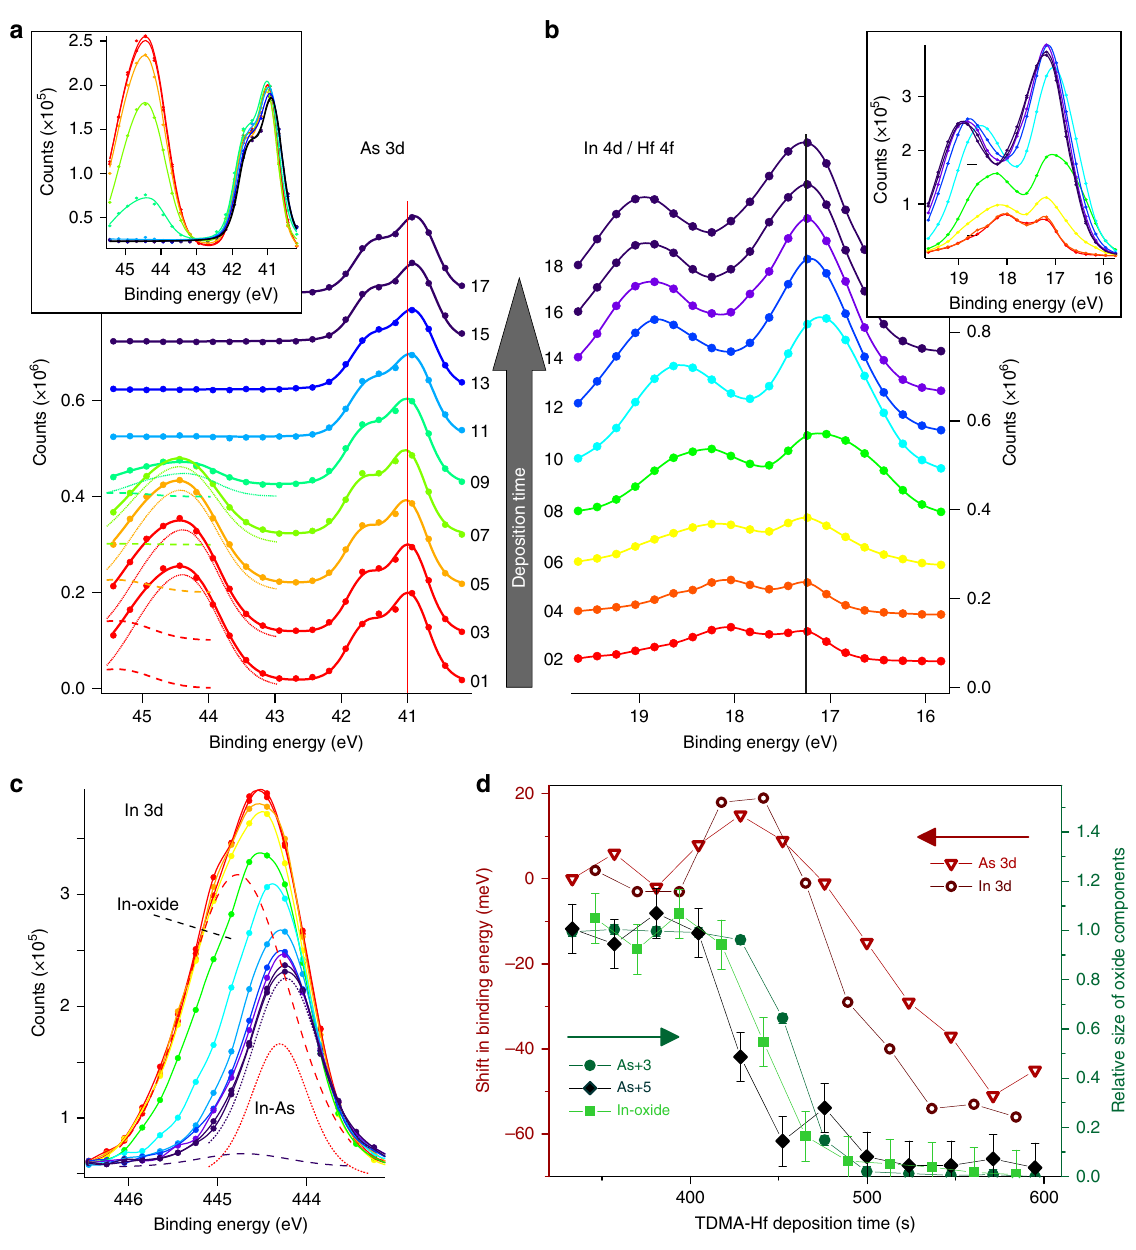
Fig. 3 Correlation of Hf surface chemistry and oxide removal. Correlated time evolution of ( a ) As 3d and ( b ) In 4d/Hf 4f core level spectra, obtained alternately during TDMA-Hf deposition of the fi rst ALD half-cycle, as indicated by the sweep index labels on each spectrum. Thereby As-oxide reduction and Hf surface chemistry can be correlated for spectra shortly before (red), during (orange, yellow, green, cyan, blue, purple), and after (dark purple) the reaction. The insets show the same spectra without being shifted along the y -axis, for easier comparison of peak heights. Experimental data are plotted by fi lled circles, while the lines in a show fi tted spectra. Fitted As 3 + and As 5 + oxide components are indicated in a by dotted and dashed lines, respectively. Contributions from different overlapping In 4d and Hf 4 f components to the spectra shown in b are plotted in Supplementary Fig. 5 and discussed in detail in Supplementary Note 5. Binding energies of the As bulk component before the reaction (red line, a ) and the Hf – O component after the reaction (dark purple line, b ) are indicated. A narrow binding energy range has been chosen for the spectra in a , b in order to minimize the acquisition time and maximize the temporal resolution. c In 3d spectra, obtained alternately with As 3d spectra (shown in Supplementary Fig. 6). Fitted In-oxide and In-arsenide (bulk) components are plotted as dashed and dotted curves, respectively, for the fi rst (red) and last (dark purple) spectra. Shifts in the binding energy of the fi tted As 3d and In 3d bulk components during the reaction are shown in d , together with the change in peak area of the As 3 + , As 5 + , and In-oxide components (with relative peak areas normalized to “ 1 ” before the onset of the reaction). Error bars correspond to uncertainties in fi tting different oxide components. The time delay between subsequent spectra from the same core level was 20 s in a , b and 24 s in c , d . Spectra were obtained at photon energies of 330 eV ( a , b ) and 570 eV ( c , d ), a gas pressure of about 0.8 Pa, and a sample temperature of